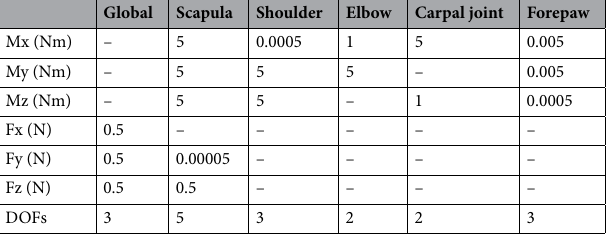
Table 1. The maximum force and torque actuator values of the joints of the left forelimb calculated with a parameter map. As well as the degrees of freedom in the joints.